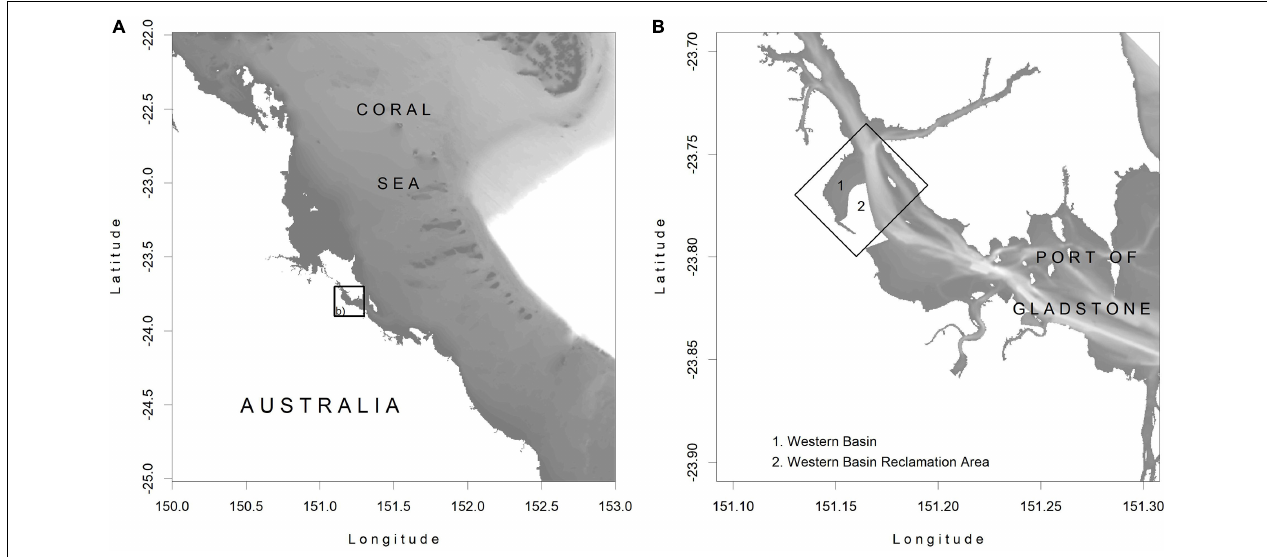
FIGURE 1 | (A) The location of the Port of Gladstone, indicated by the box, relative to the Coral Sea, at the southern extent of the Great Barrier Reef World Heritage Area; (B) the location of the Western Bason Reclamation Area, whose western limit is considered for the “living seawall,” is shown within the Port of Gladstone.